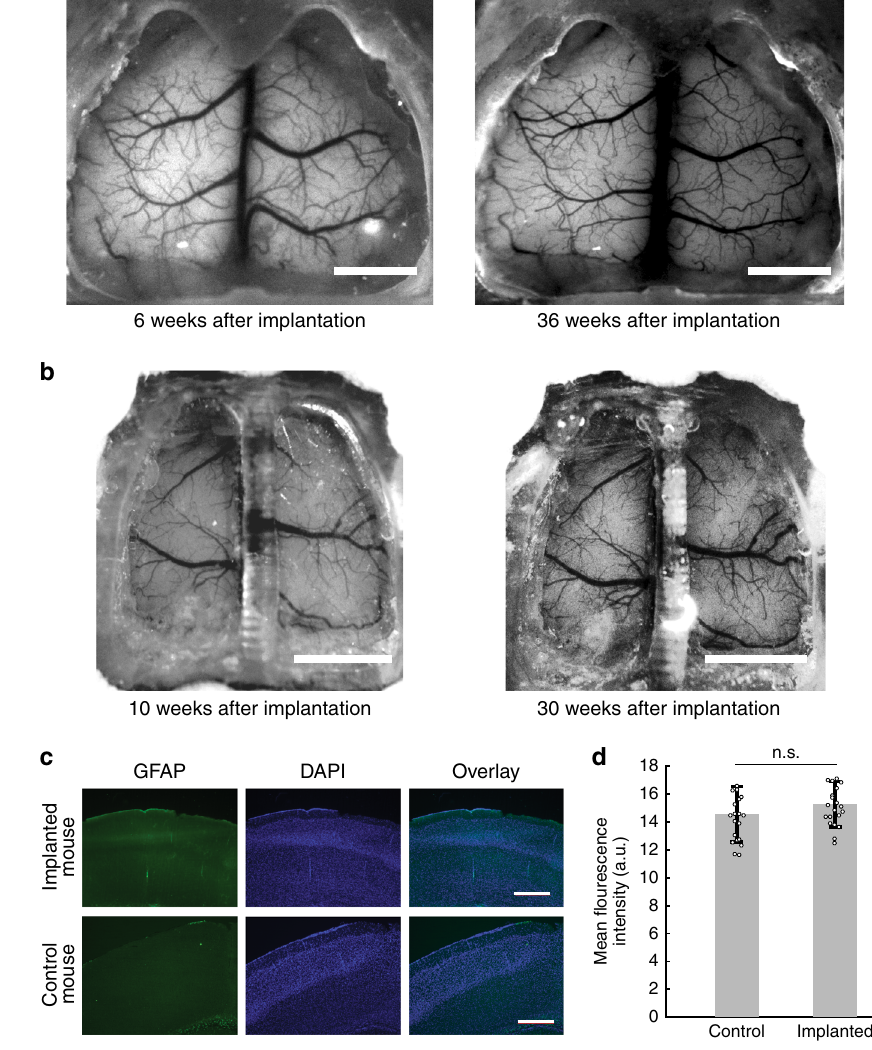
Fig. 2 Chronic implantation of See-Shells. a Photographs of a Thy1-GCaMP6f mouse 6 and 36 weeks after implantation with See-Shells. Scale bars indicate 2 mm. b The design can be modi fi ed to fi t different skull morphologies. Photographs of a tg/tg mouse 10 and 30 weeks after implantation. Scale bar indicates 2 mm. c Immunohistology analysis of mice chronically implanted with See-Shells for 5 weeks compared to age-matched non-surgical control mice at ~2.0 mm posterior to bregma and 1.5 mm lateral to the midline. Coronal slices were immunolabeled with anti-glial fi brillary acidic protein (anti-GFAP) and DAPI. No activated astrocytes were observed in any of the mice assessed. Scale bar indicates 500 µ m. d Bar plots overlaid with the dot plots of mean GFAP fl uorescence measured in 21 regions of interest (ROIs) in See-Shell implanted and non-surgical control mice. Error bars indicate